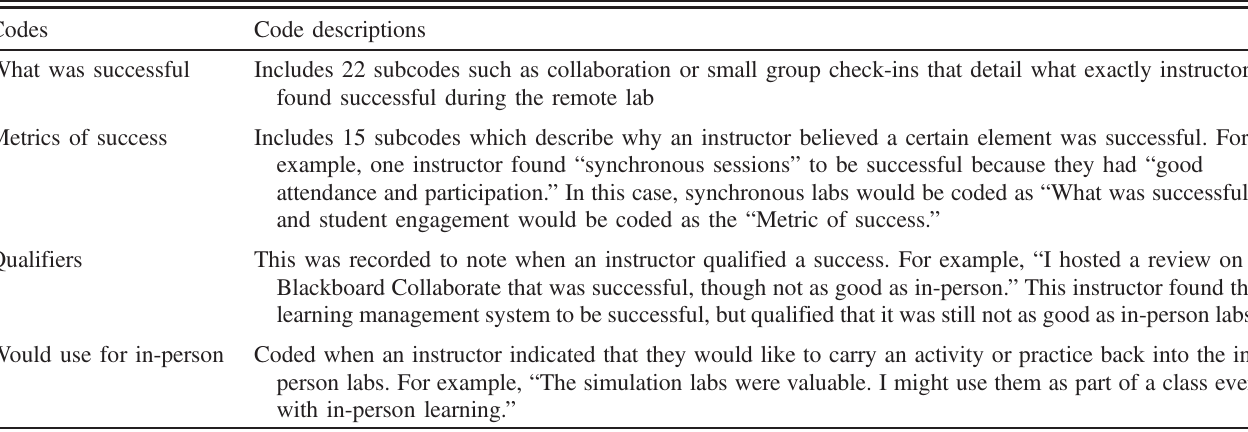
TABLE IV. Description of major codes in second code book used for “ successes ”